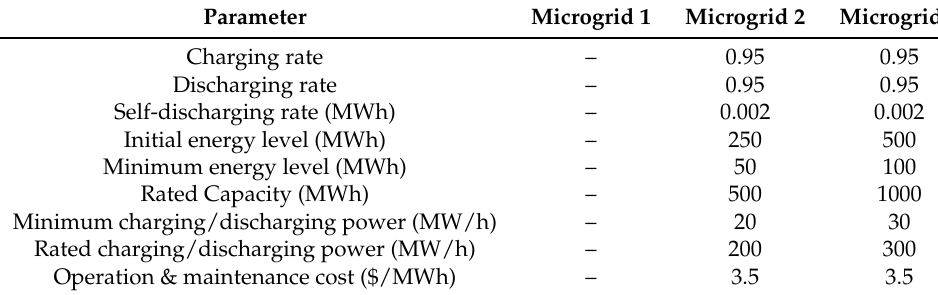
Table 2. ES parameters. – : Not applicable.